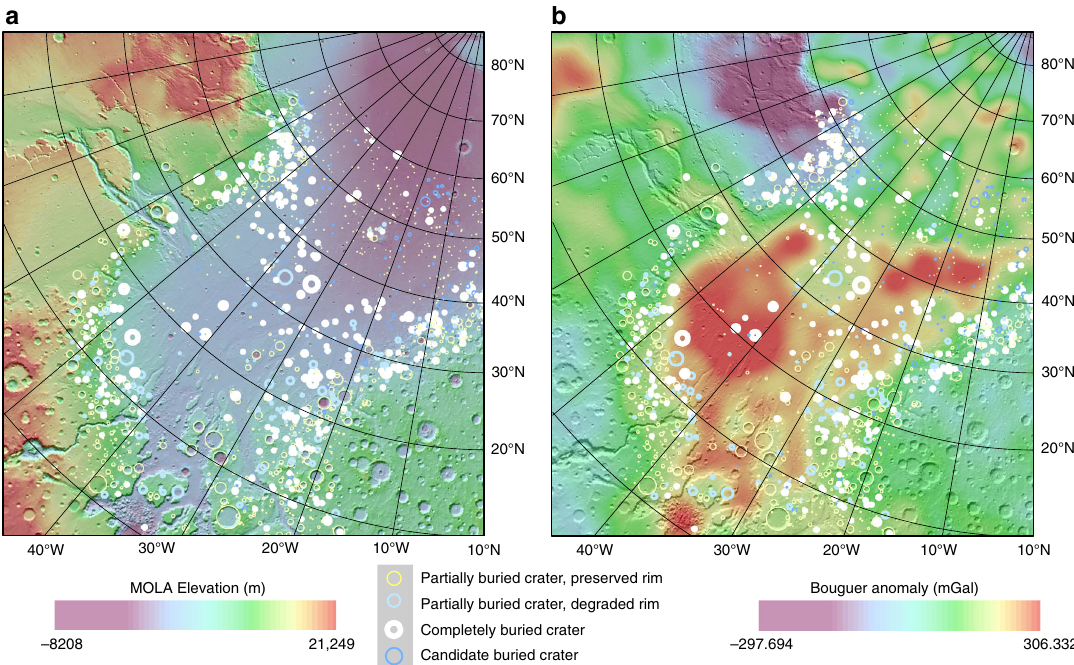
Fig. 1 Map of buried crater distribution within the Chryse and Acidalia Planitia overlain on a Topography from Mars Orbiter Laser Altimeter (MOLA) data; 22 and b Goddard Mars Model 3 gravity data, Bouguer anomaly 20 . The base maps are projected using the Mars North Polar Stereographic